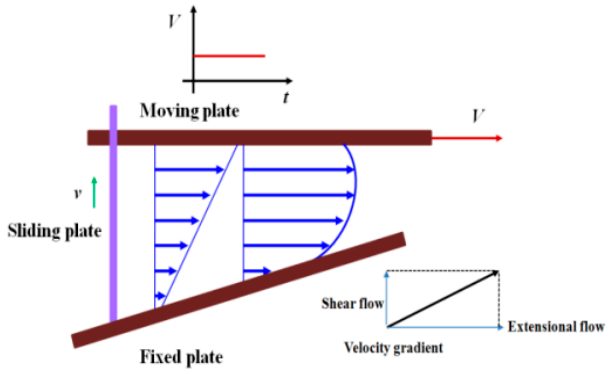
Figure 1. Schematic diagram of extensional–shear coupled flow.